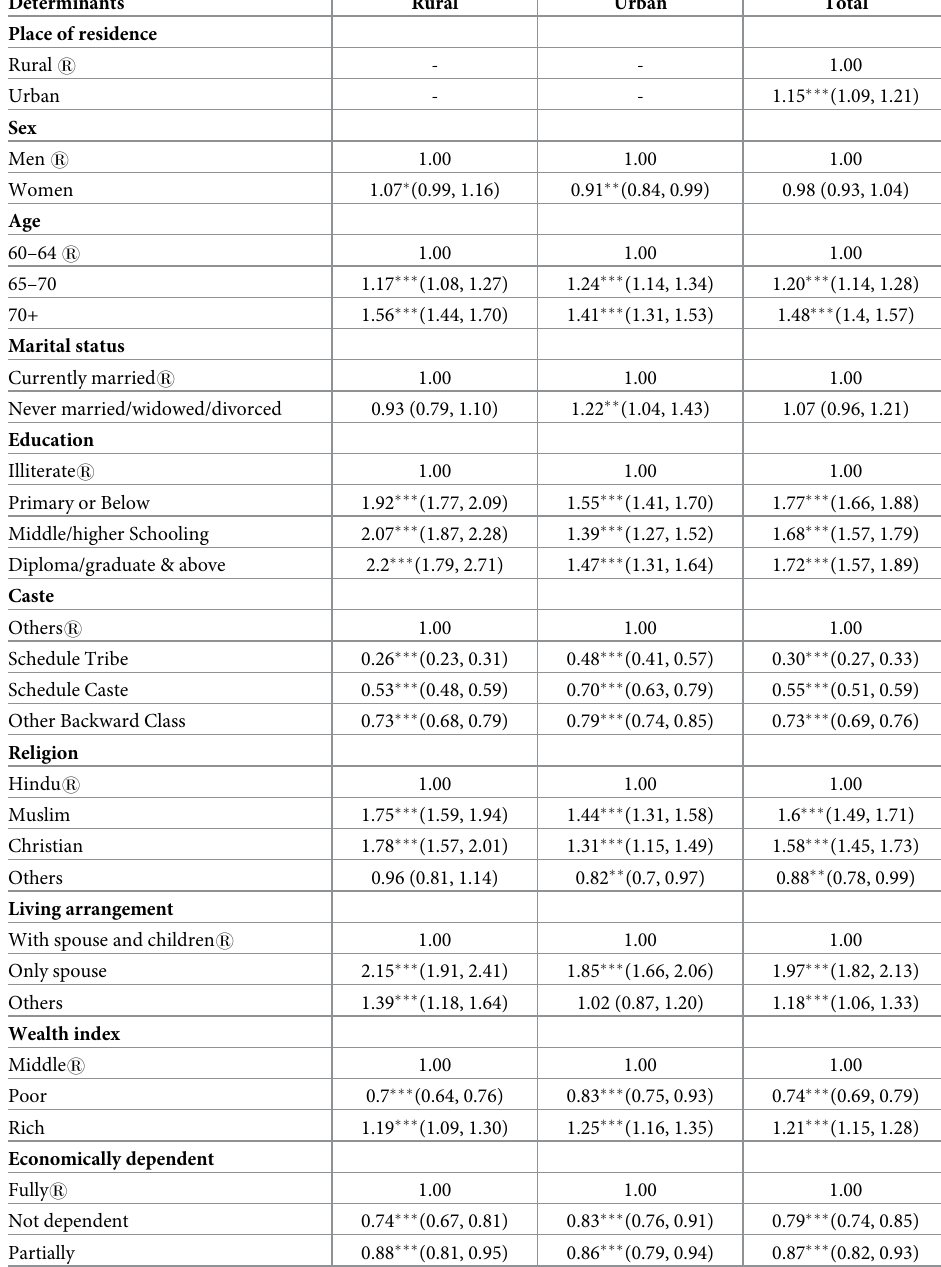
Table 3. Odds ratio and 95% Confidence Interval (CI) of any chronic disease associated with background charac- teristics by place of residence in India,